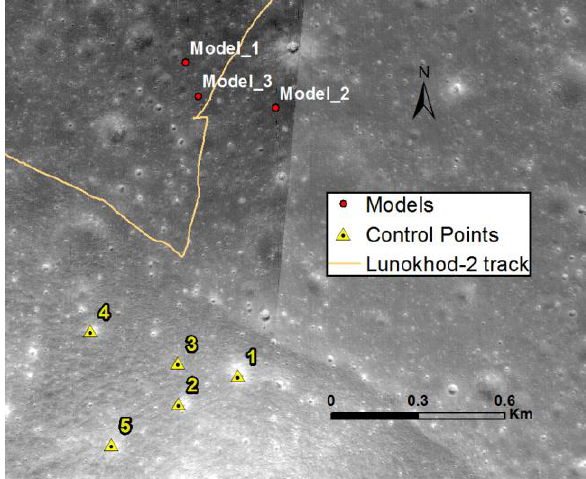
Figure 3 (a, b). Example of measurements of ground control points on synthetic images.